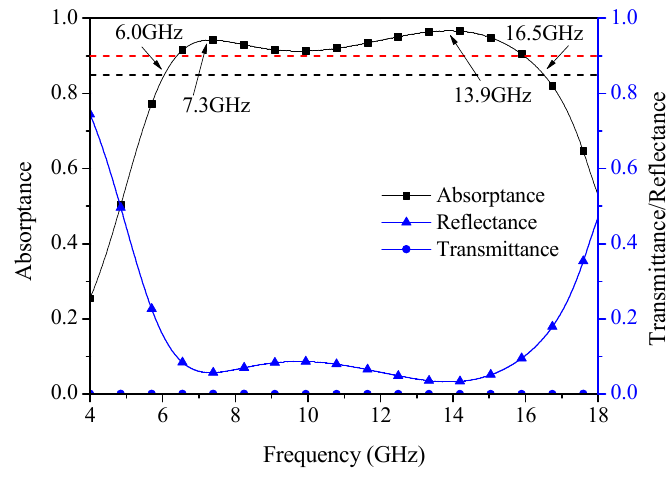
Figure 2. The characteristics of the proposed absorber.